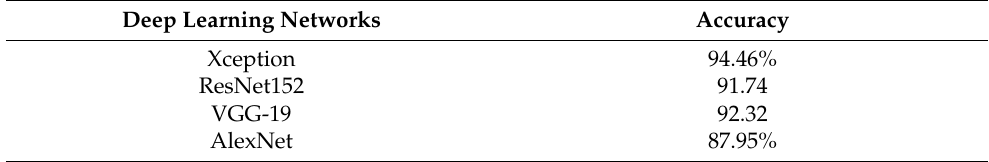
Table 1. Accuracy of each model.